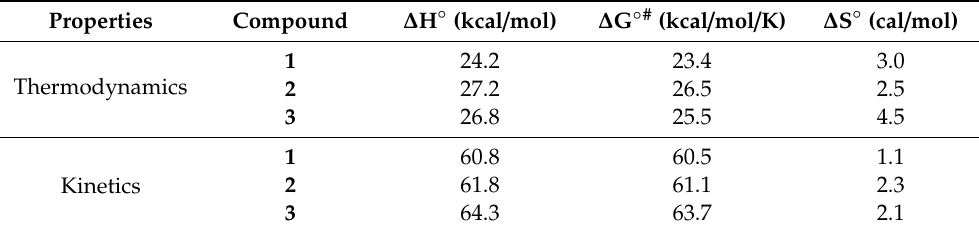
Table 6. Calculated reaction profile using the 6 − 311G++(d,p) basis set.